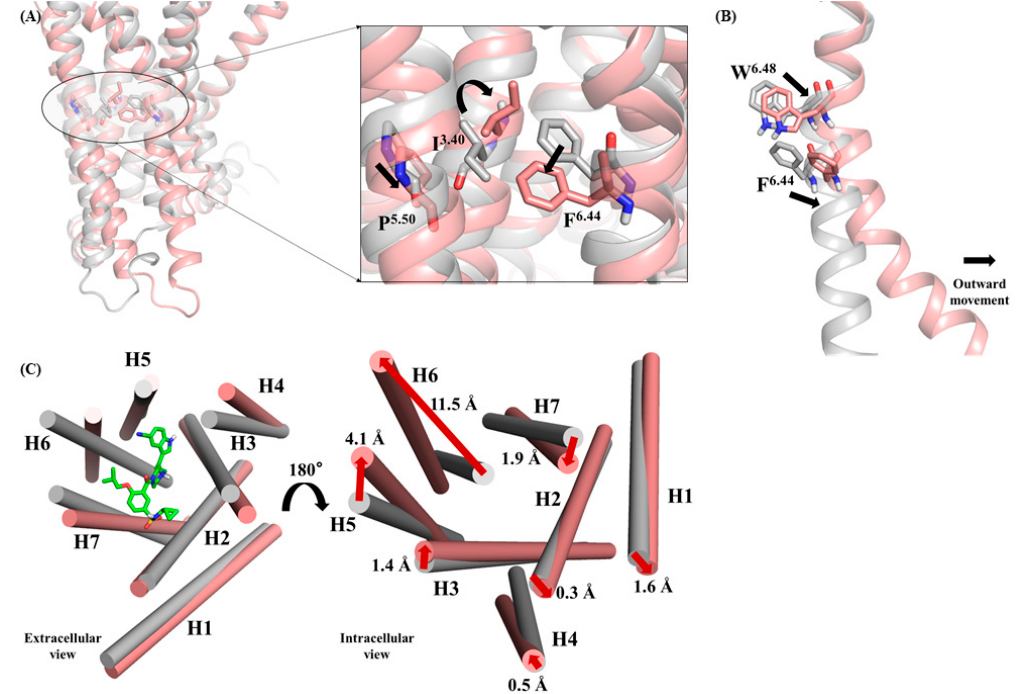
Figure 5. ( A ) Superimposed structures of apo and 13m -5-HT 1A R systems and the rearrangements of I3.40, P5.50 and F6.44 when 13m was bound to 5-HT 1A R. ( B ) the movement of rotamer toggle switch W6.48 in 13m -5-HT 1A R system contributed to the movement of the TM6. ( C ) Superimposed structures of apo and 13m -5-HT 1A R systems and the rearrangements of I3.40, P5.50, and F6.44 when 13m was bound to 5-HT 1A R. The apo system and surrounding residues are represented as grey. The 13m -5-HT 1A R system and surrounding residues are represented as pink.